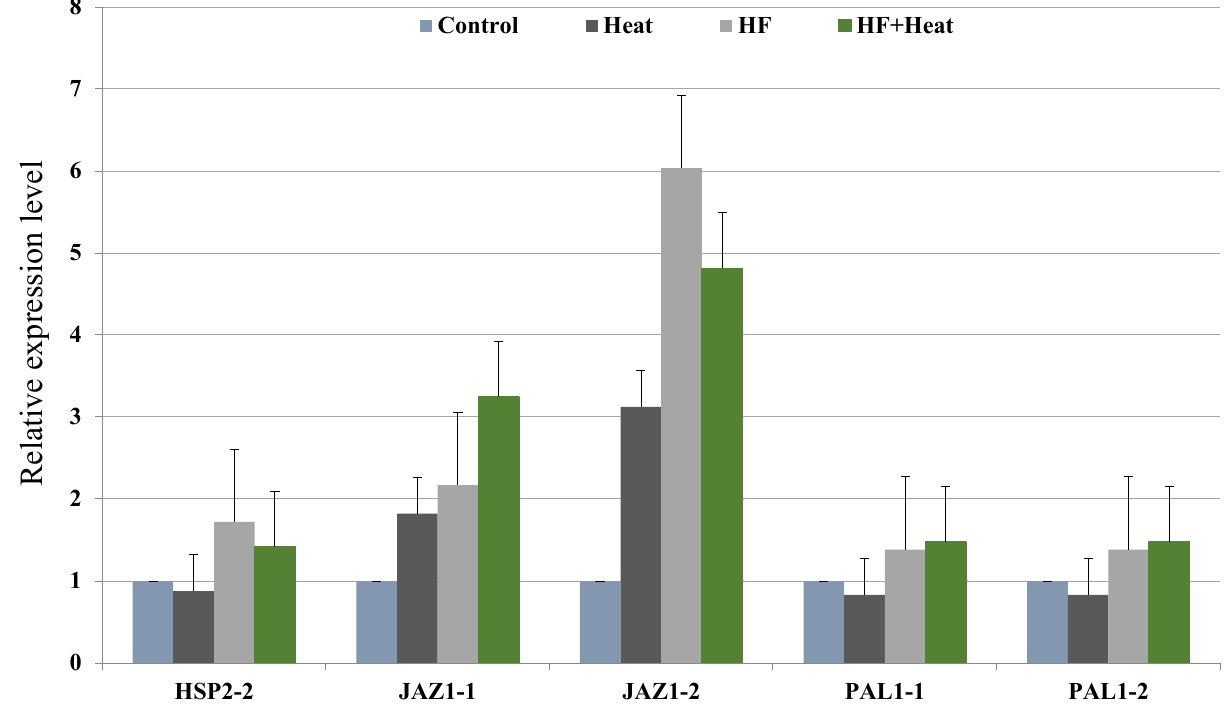
Figure 1. Relative expression level of 3 DEGs in response to heat, HF, and heat plus HF stresses. Error bars were calculated using standard errors of three biological replicates. Table 2. Genes and oligonucleotide sequences of primer pairs used for real-time qPCR.